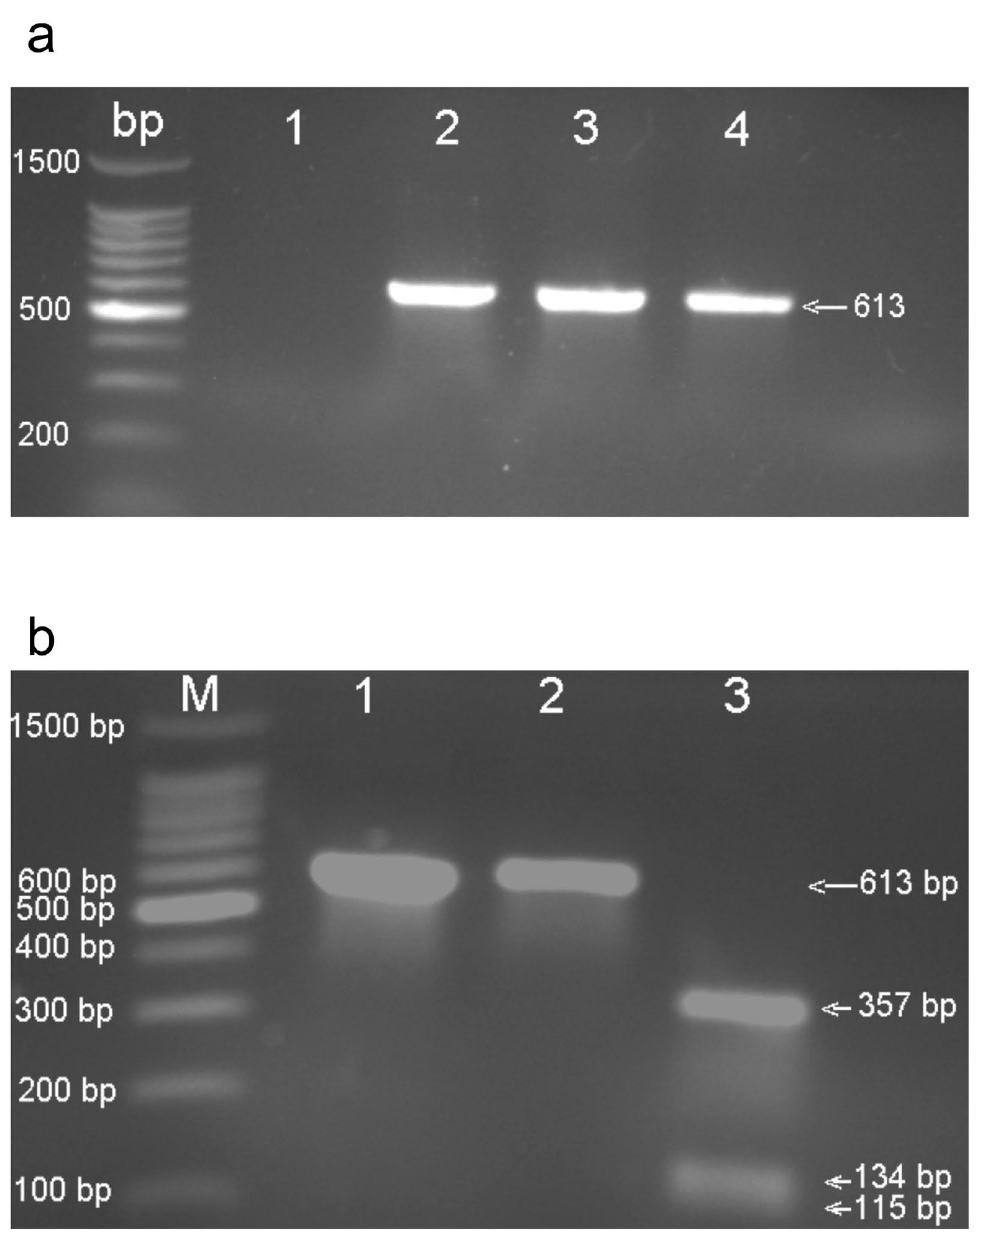
Figure 1. (a) Agarose gel of products amplified from Prune dwarf ilarvirus . M, Marker; lane 1, negative control; lane 2, positive control (provided by Bio-Rad, France), lane 3, fragment amplified of PDV isolate Jemmal1 from the natural host, almond; lane 4, fragment amplified from Cucumis sativus cv. Marketer. The arrow shows the fragment size obtained (613 bp). (b) RFLP analysis of PCR products. Lane 1, uncleaved amplicon; lane 2, PCR product subjected to Ava II endonuclease (no digestion); lane 3, amplicon digested by Rsa I restriction enzyme. The arrows show the uncleaved PCR product (613 bp), and the digested fragment having the following sizes: 357, 134, and 115